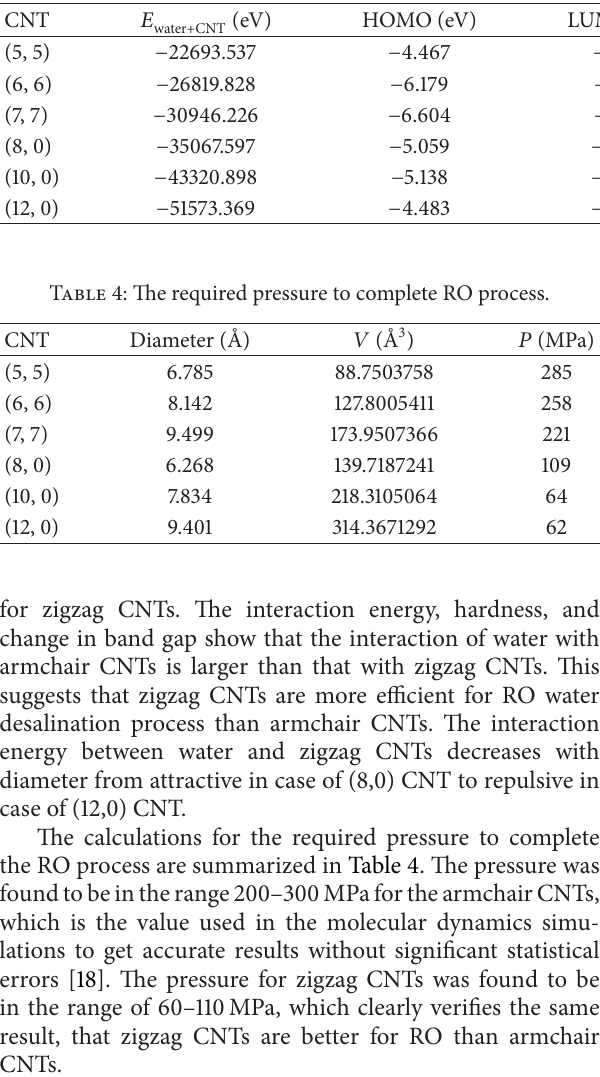
Table 3: The energy of CNT with water, 𝐸